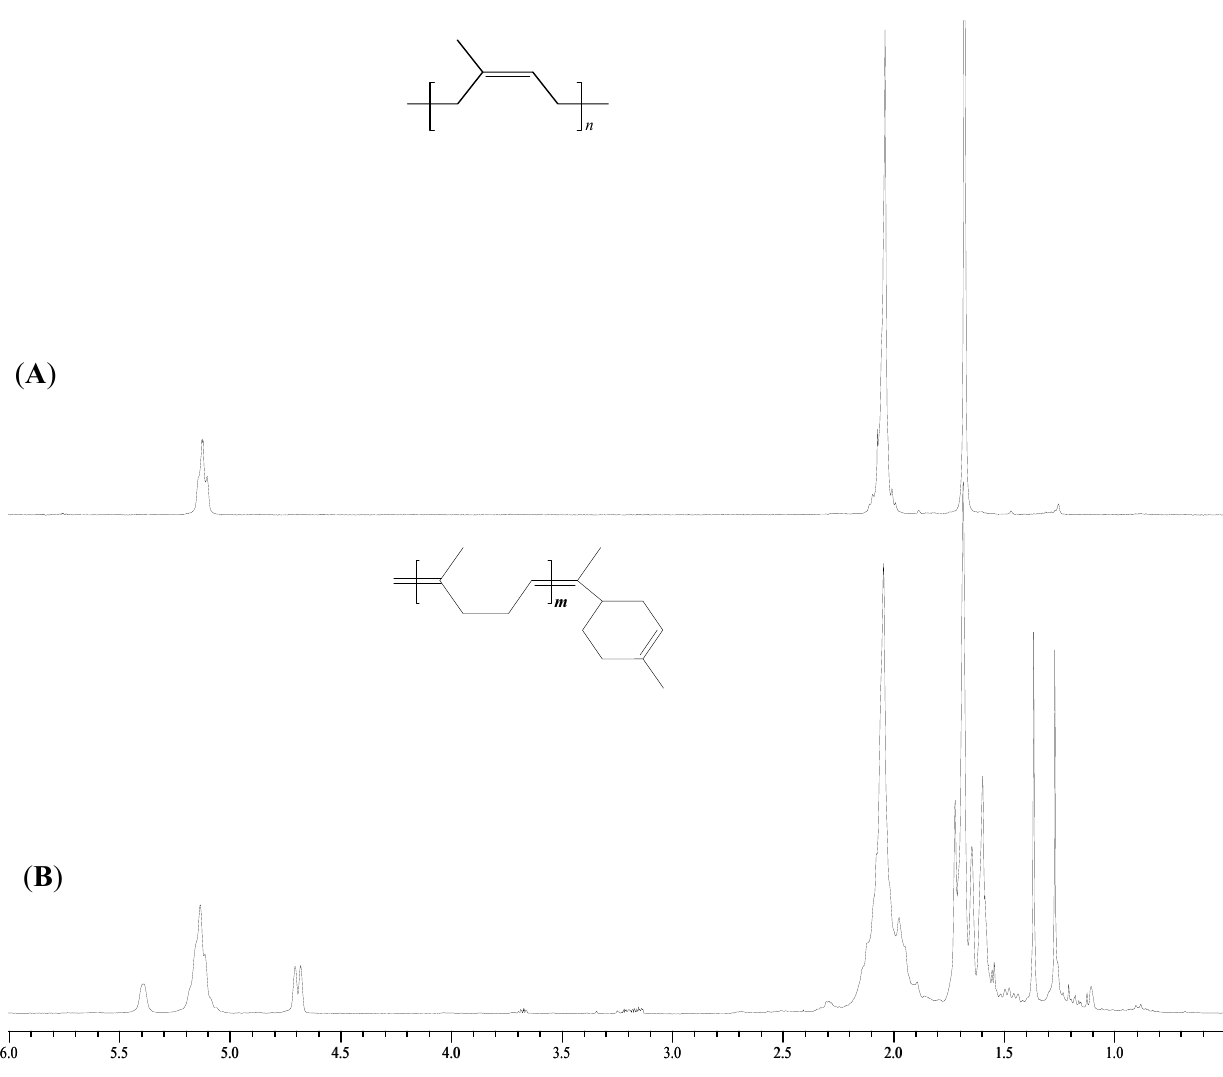
Figure 1. 1 H-NMR (300 MHz, CDCl cross-metathesis degradation with d